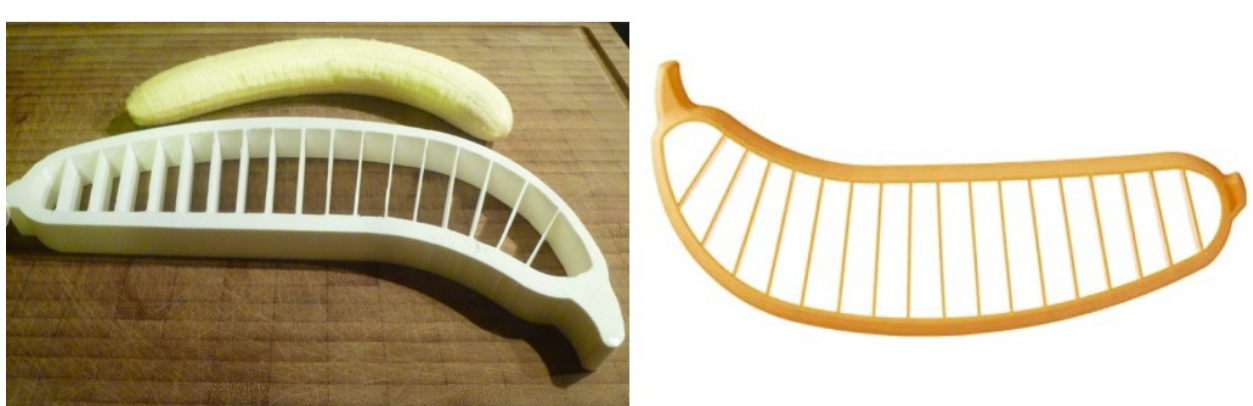
Figure 5: Comparison of open source version (left) and the commercial version (right) of the banana slicer (Hüger LP, 2021; Amazon, 2021c).